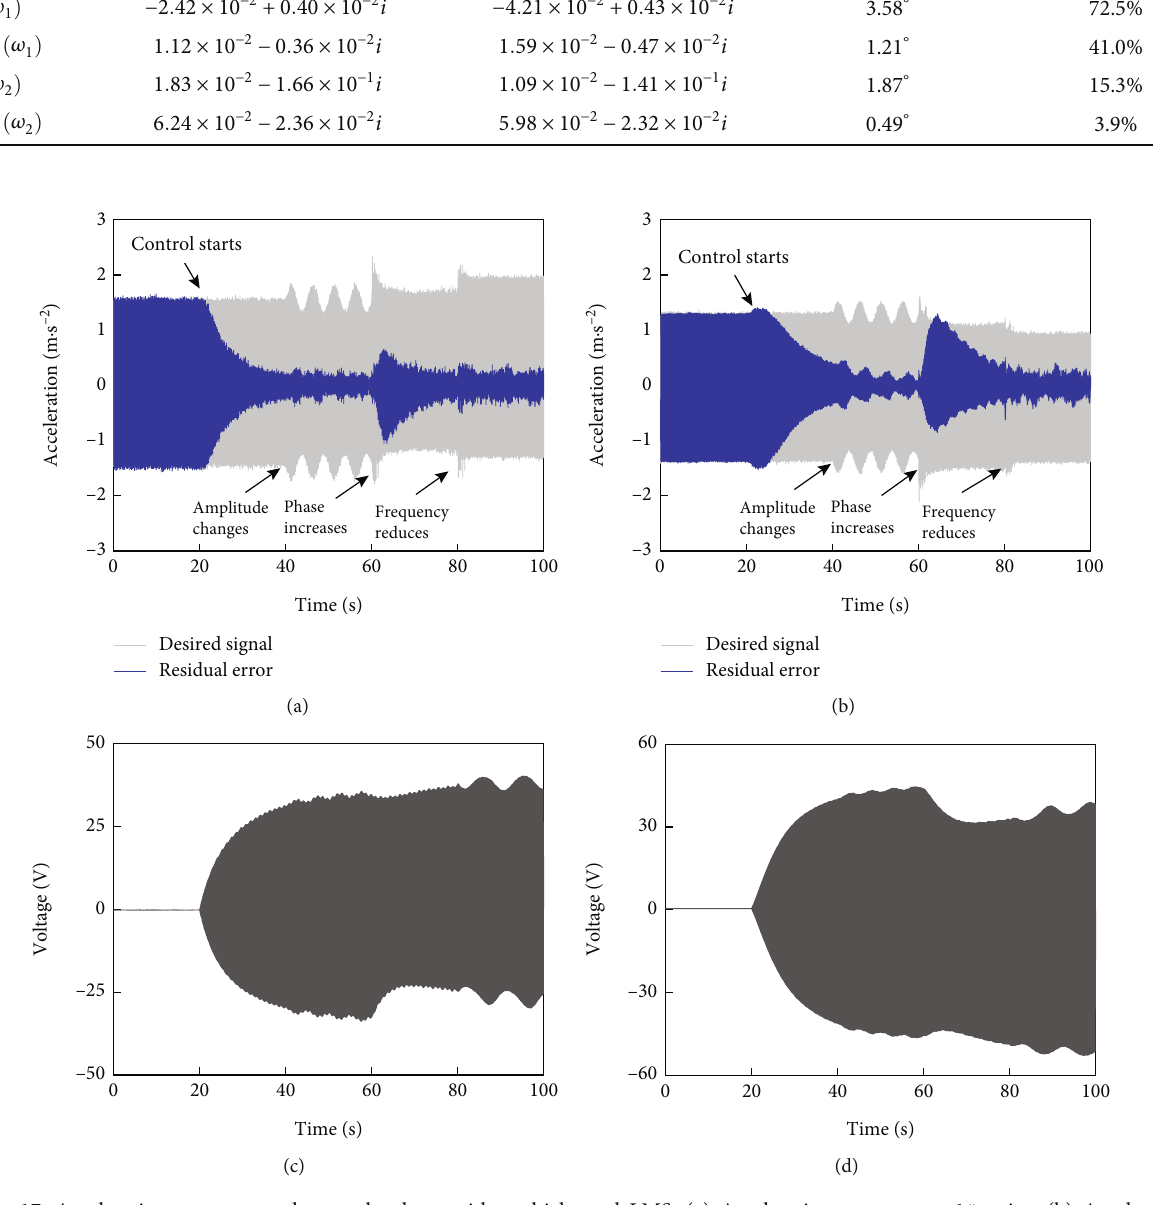
Figure 17: Acceleration response and control voltage with multichannel LMS. (a) Acceleration response at 1# point. (b) Acceleration response at 2# point. (c) Control voltage of 1# PSA. (d) Control voltage of 2# PSA.